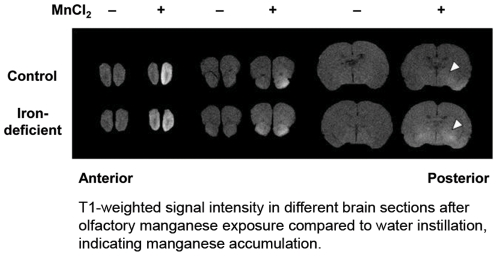
Manganese accumulation in the brain after intranasal instillation.MnCl2 was instilled into the right nostril of rats three times on days 1, 4, and 6 (30 mg/kg). Distilled water was used as a vehicle control. Two days following the last instillation, MR images were taken from isoflurane-anesthetized rats using a 4.7T MR device to assess signal intensity on T1-weighted images of axial sections of the brain with a thickness of 1 mm. Arrowheads indicate the striatum.